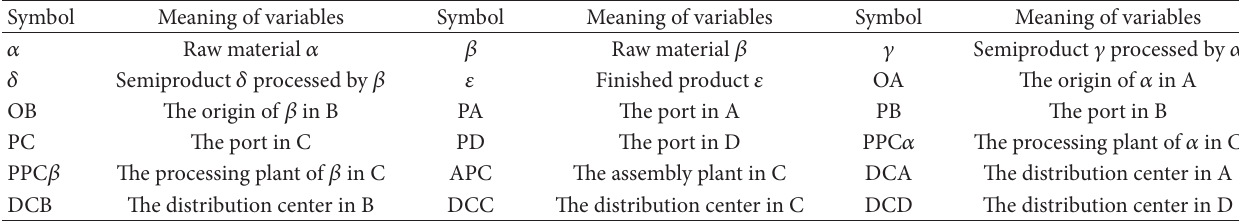
Table 1: Variable symbol of international supply